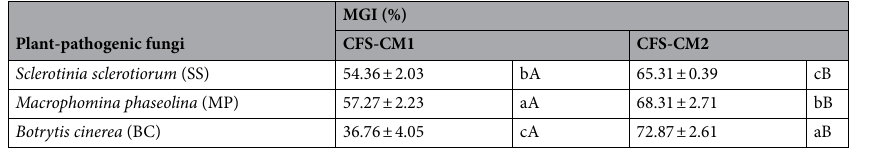
Table 1. Antifungal activity against Sclerotinia sclerotiorum (SS), Macrophomina phaseolina (MP), and Botrytis cinerea (BC) of the cell-free supernatants (CFS) obtained by submerged liquid fermentation of Bacillus velezensis CMRP 4489 in two culture media (CM1 and CM2). MGI (%) ± Standard Error. Numbers followed by the same lowercase letter in the column ( p < 0.05) and uppercase letter in the row ( p < 0.01) did not differ according to Tukey’s test.